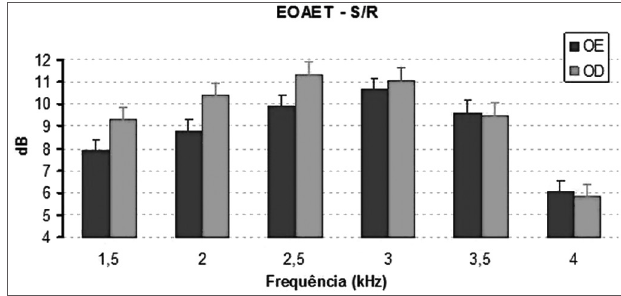
Figura 1. Média e desvio padrão das amplitudes das EOAT registradas para cada gênero em cada frequência. F: Feminino; M: Masculino. Teste ANOVA, p < 0,001.